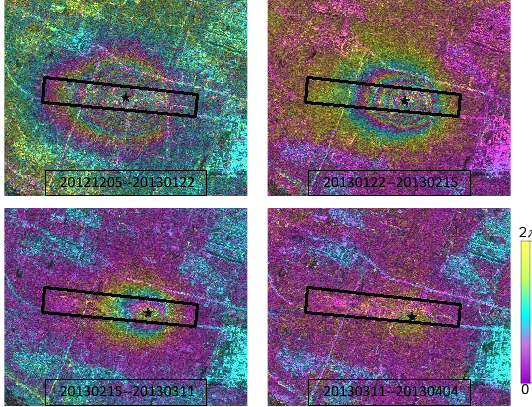
Figure 5. The differential interferograms of study area